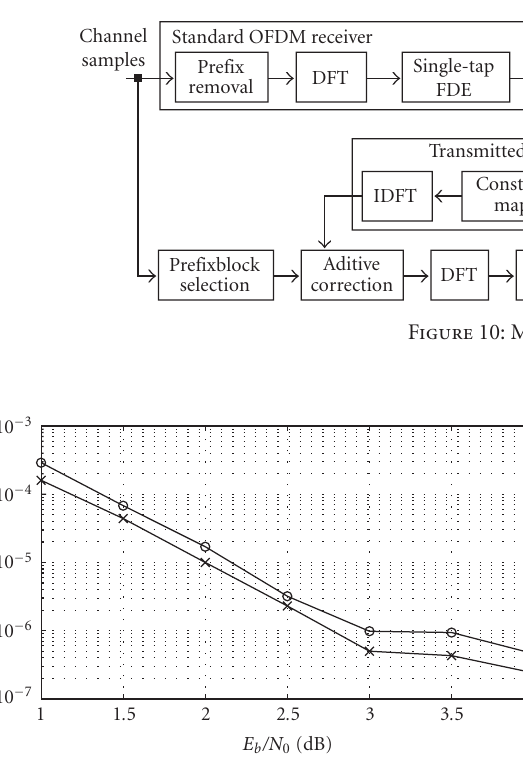
Figure 11: Standard ( ◦ -marker) and modified ( × -marker) receiver error performance after 8 decoder